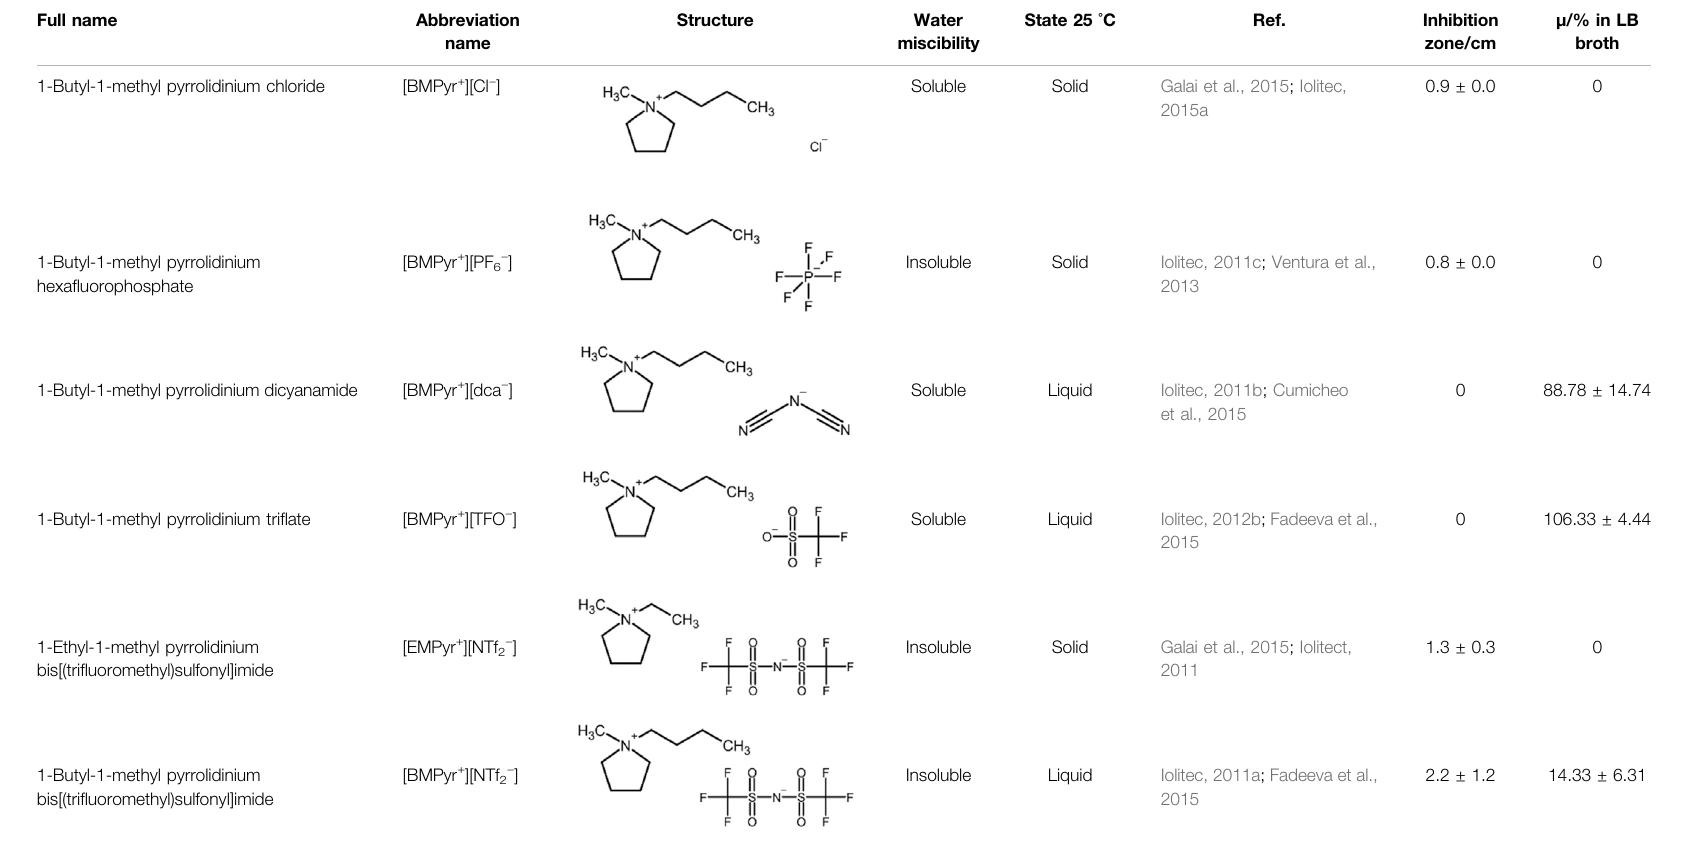
TABLE 3 | Pyrrolidinium-based ionic